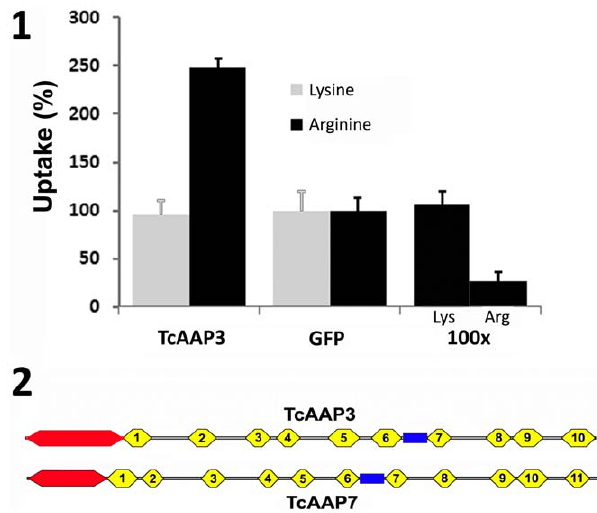
Figure 1. Substrate specificity of TcAAP3. 1) Radiolabeled L- arginine (100 m M, black) or L-lysine (100 m M, grey) uptake was measured in TcAAP3 over-expressing parasites (TcAAP3), GFP controls (GFP), and in the presence of 100-fold molar excess of lysine (Lys) or arginine (Arg). Uptake rates of arginine and lysine are expressed as a percentage of the GFP controls and correspond to 93 and 21